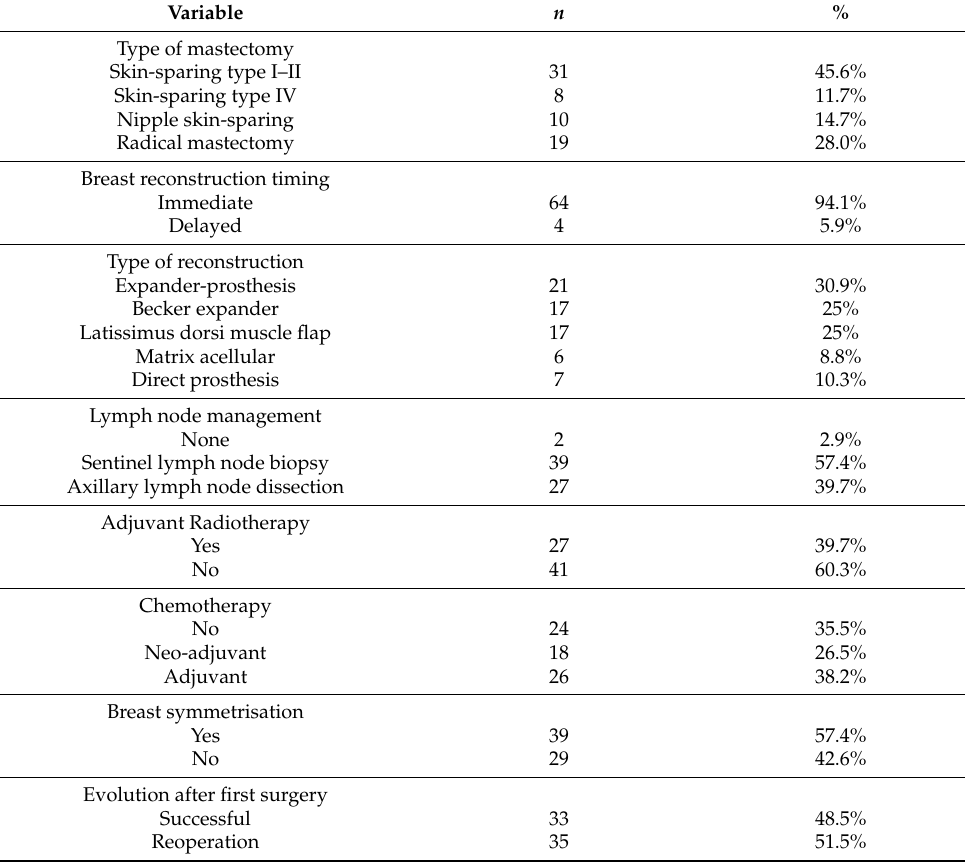
Table 3. Characteristics of surgery, adjuvant therapy and evolution of